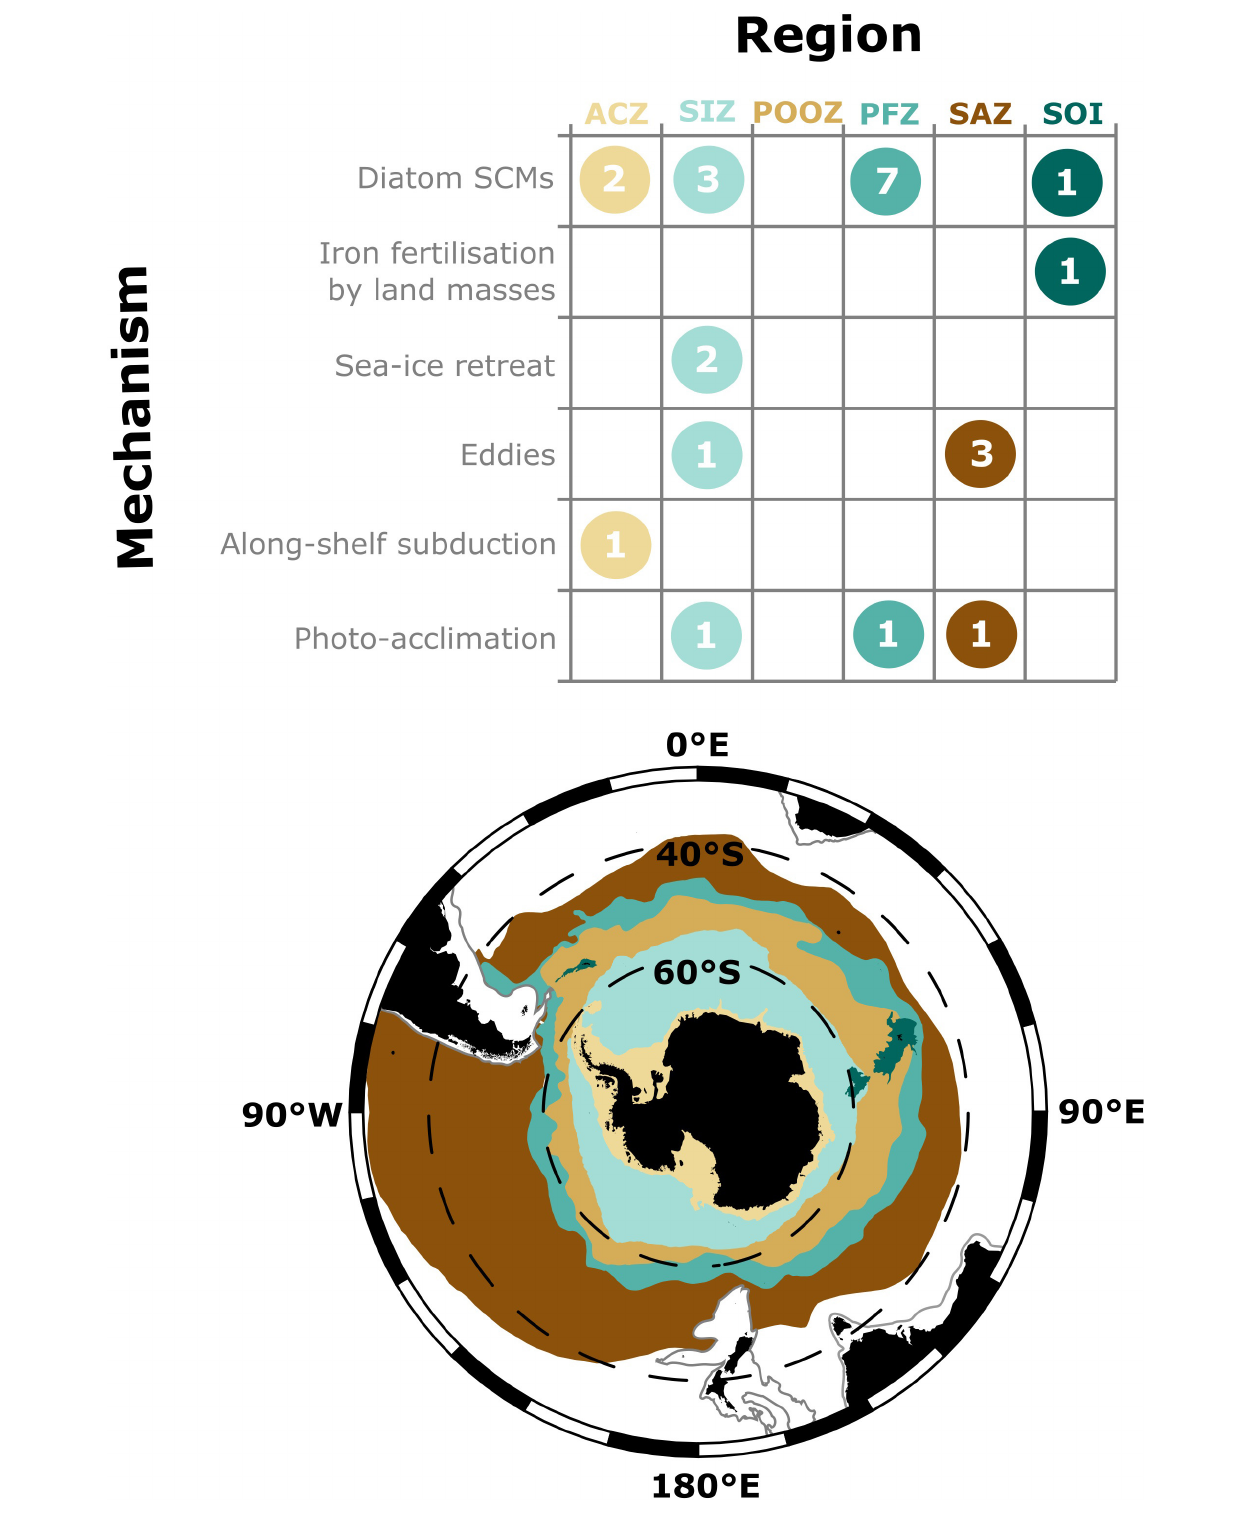
FIGURE 4 | The number of studies that identify a mechanism of formation discussed in this review presented by region of the Southern Ocean. The evidence each study has given for these mechanisms is given in Supplementary Table S2 . Regions are as defined in Deppeler and Davidson (2017), however, note that the location of fronts and sea-ice extent are highly variable. ACZ, Antarctic Coastal Zone (including continental slope to 2000 m); SIZ, Seasonal Ice Zone; POOZ, Permanently Open Ocean Zone; PFZ, Polar Frontal Zone; SAZ, Sub-Antarctic Zone; SOI, Southern Ocean Islands. The 2000 m isobar is shown as a gray line.